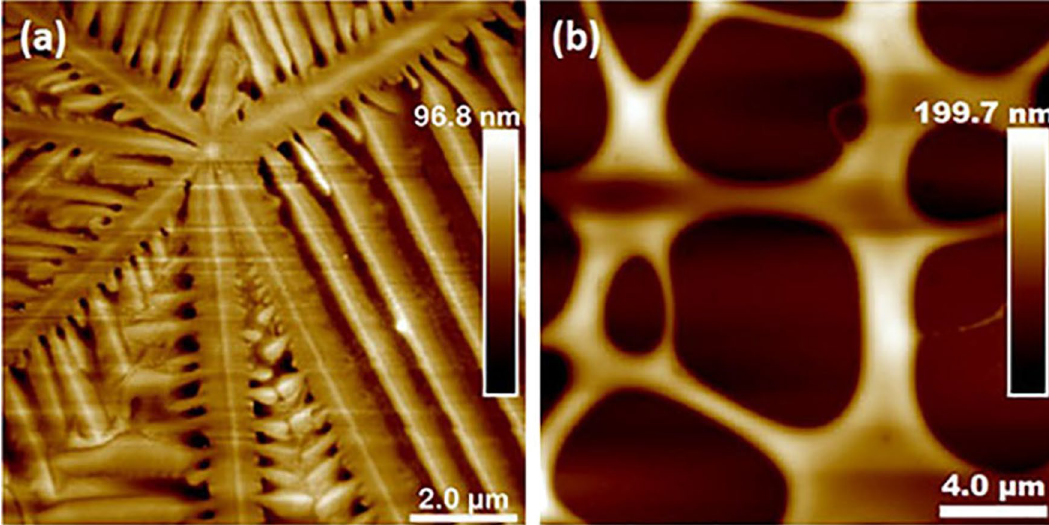
Figure 10. AFM images of ( a ) crystalline Si 0.48 Ge 0.53 O 2 on a SrTiO 3 substrate. ( b ) the evaporation pits observed in the same sample, revealing the bare